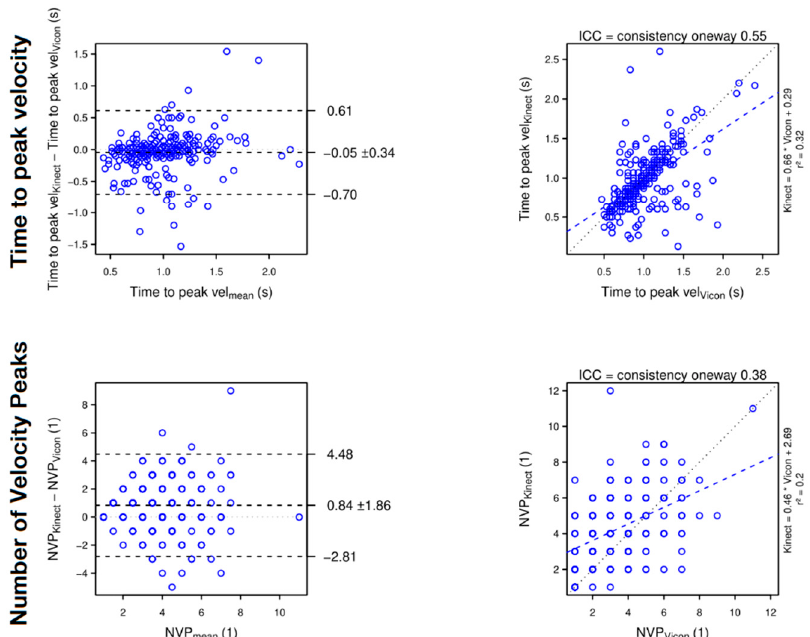
Figure 5. Bland–Altman plots ( left panels ) and regression plots ( right panels ) of movement time (1st row), path length ratio (2nd row), time to peak velocity (3rd row) and hand number of velocity peaks (4th row). The Bland–Altman plots show that the Kinect has almost no systematic error on the movement time and time to peak velocity but slightly overestimates the path length ratio and the number of velocity peaks. The regression plots show that, when assessed with the Kinect, the movement time is reliable, the path length ratio and the time to peak velocity are moderately reliable, but the number of velocity peaks is poorly reliable.